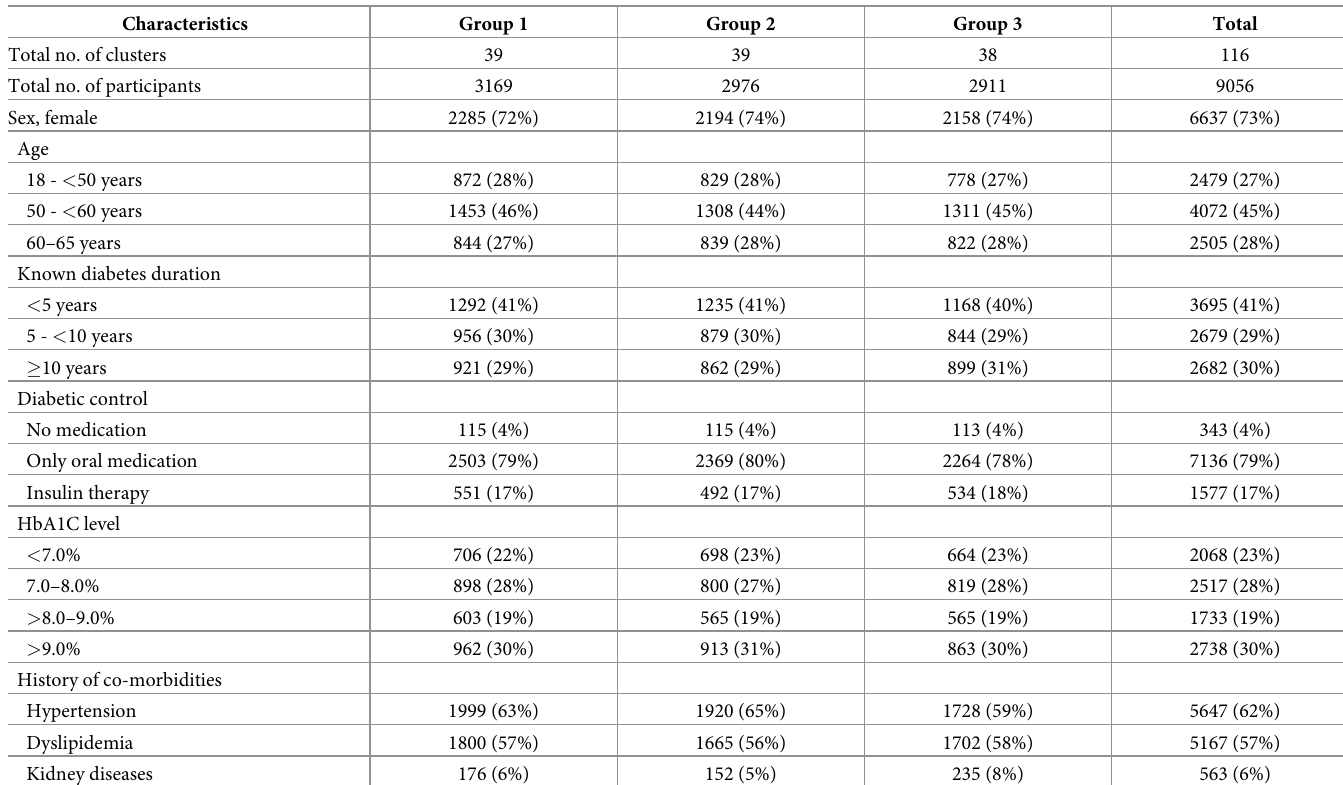
Table 1. Baseline characteristics at